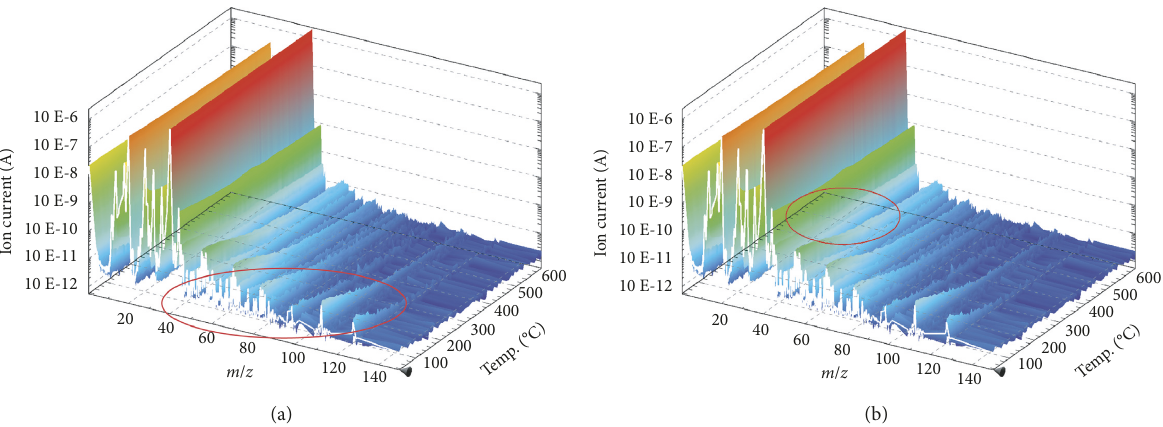
Figure 6: Mass spectrometric study of volatile products of wheat straw pyrolysis without additives (a) and with 10wt.% CuCl